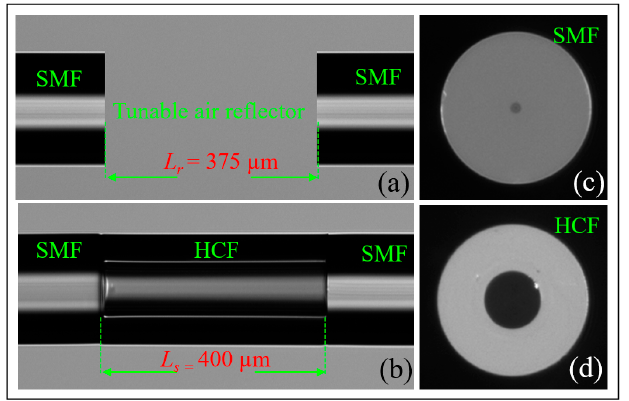
Figure 4. Microscopic images of the proposed sensor: ( a ) longitudinal cross-section of ( a ) tunable reference FPI ( b ) sensing FPI, and transverse cross-section of ( c ) SMF ( d ) HCF.